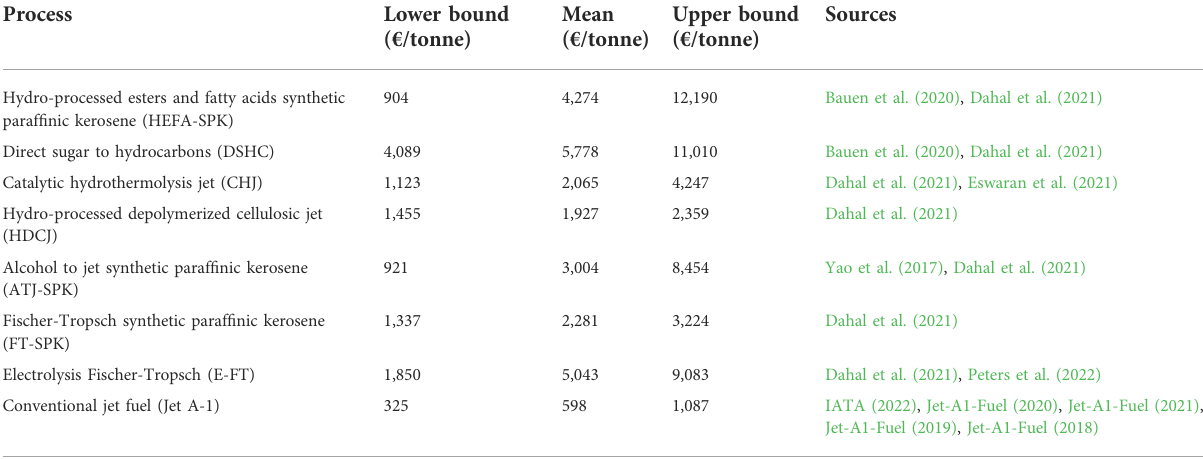
TABLE 2 MVSP ranges for the SAF benchmarks selected for the study.